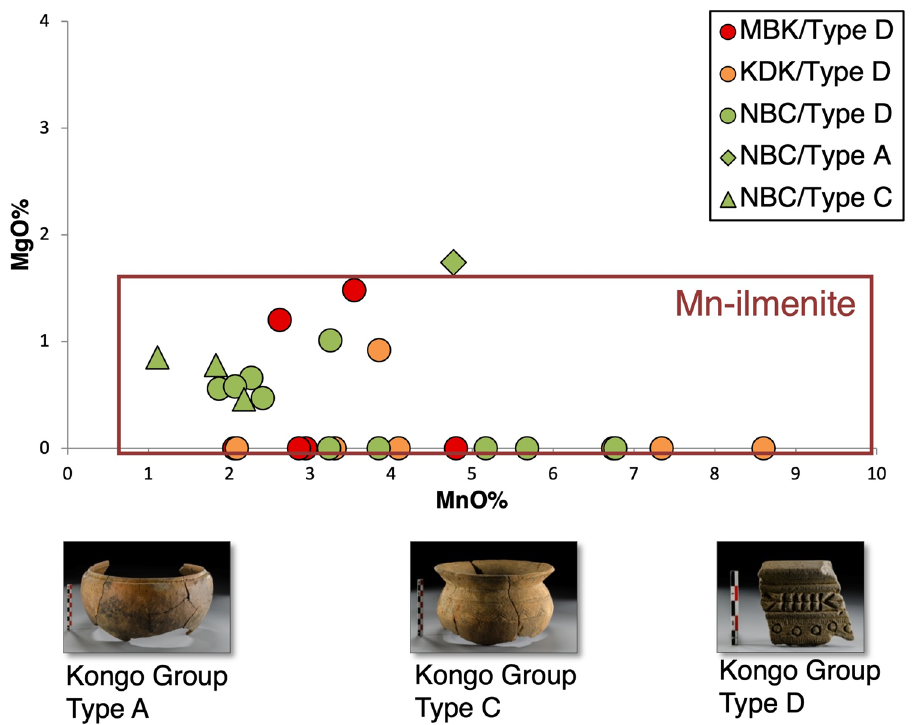
Figure 10. VP-SEM-EDS data. Scatter plot of MgO–MnO, selected samples with identified ilmenite grains from Mbanza Kongo (MBK), Kindoki (KDK) and Ngongo Mbata (NBC), indicating the manganoan-ilmenites (Mn-ilmenites) based on the study of Kaminsky and Belousova 49